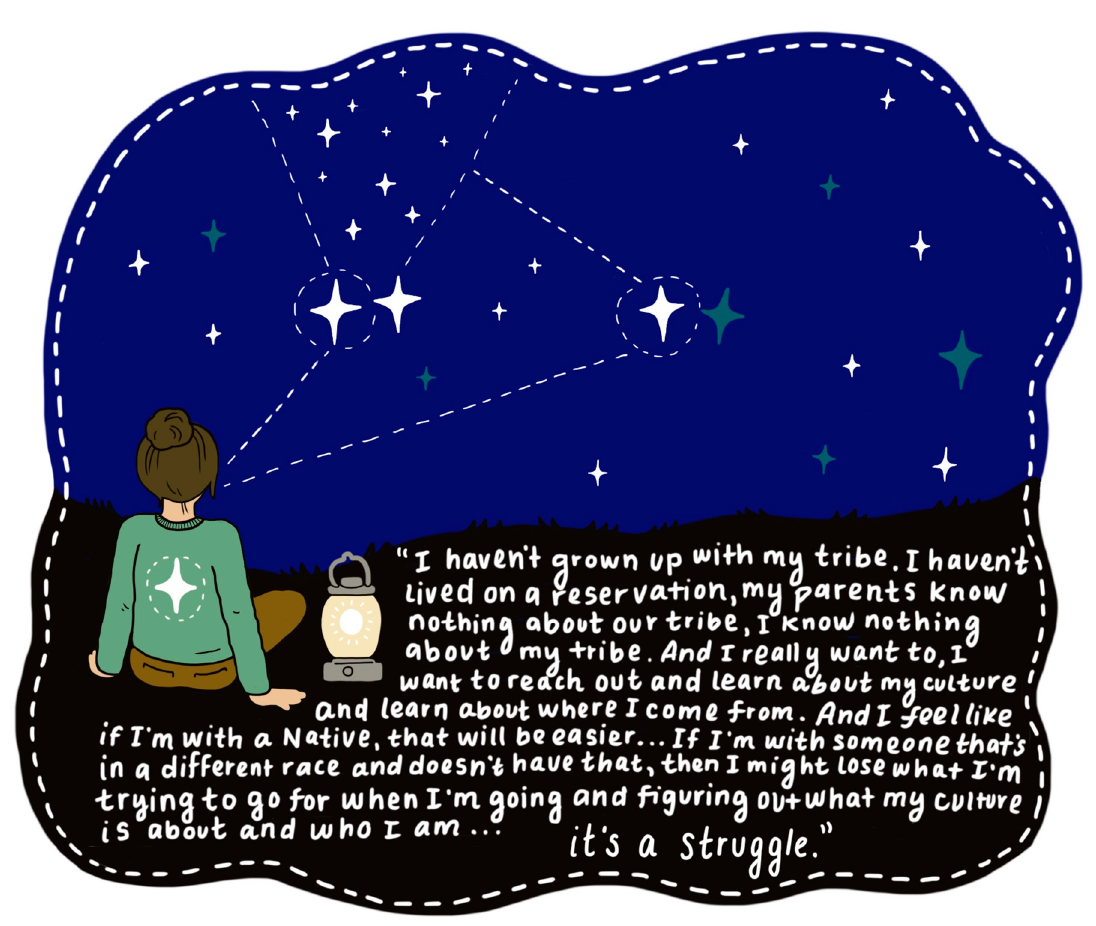
Figure 8. The image represents distance and separation between self and tribal community as the distance between a star gazer and the stars. See I.D. 8 in Appendix